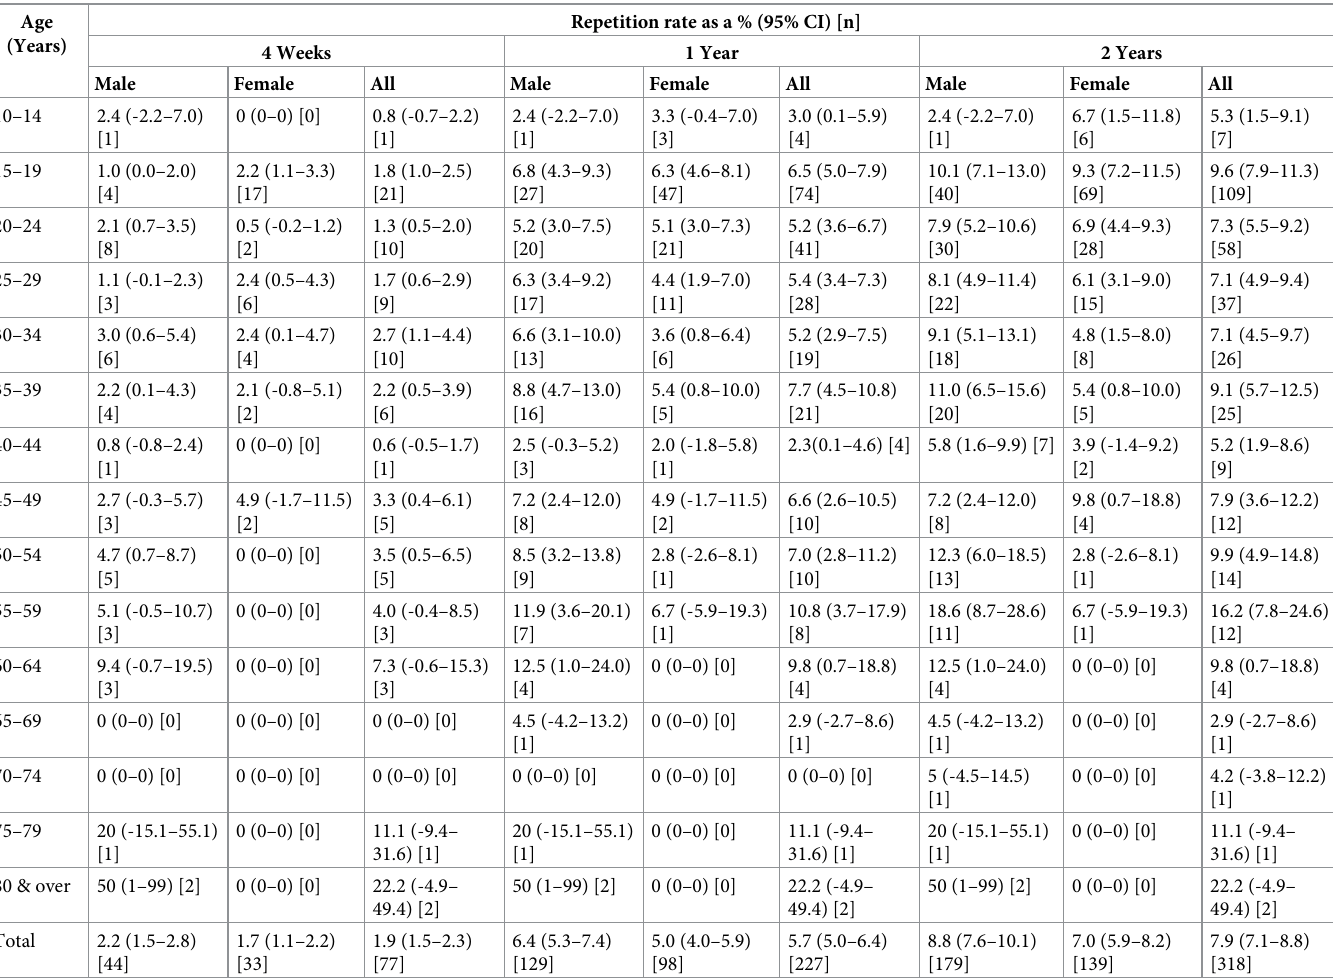
Table 2. Rates of repetition at four weeks, one year and two years, by age and